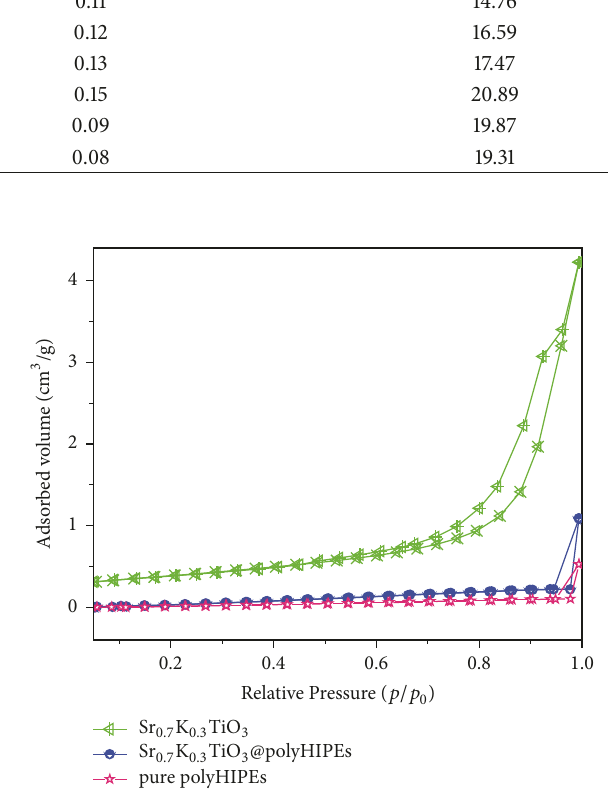
Figure 4: N 2 adsorption-desorption isotherms of Sr 0.7 K 0.3 TiO 3−𝛿 , PC-polyHIPEs, and Sr 0.7 K 0.3 TiO 3−𝛿